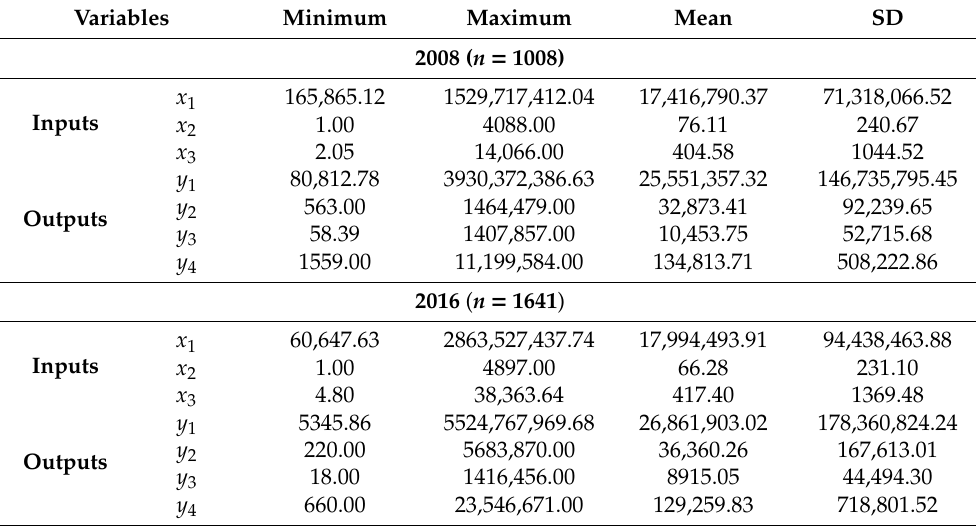
Table A2. Descriptive statistics of input and output variables, 2008 and 2016.